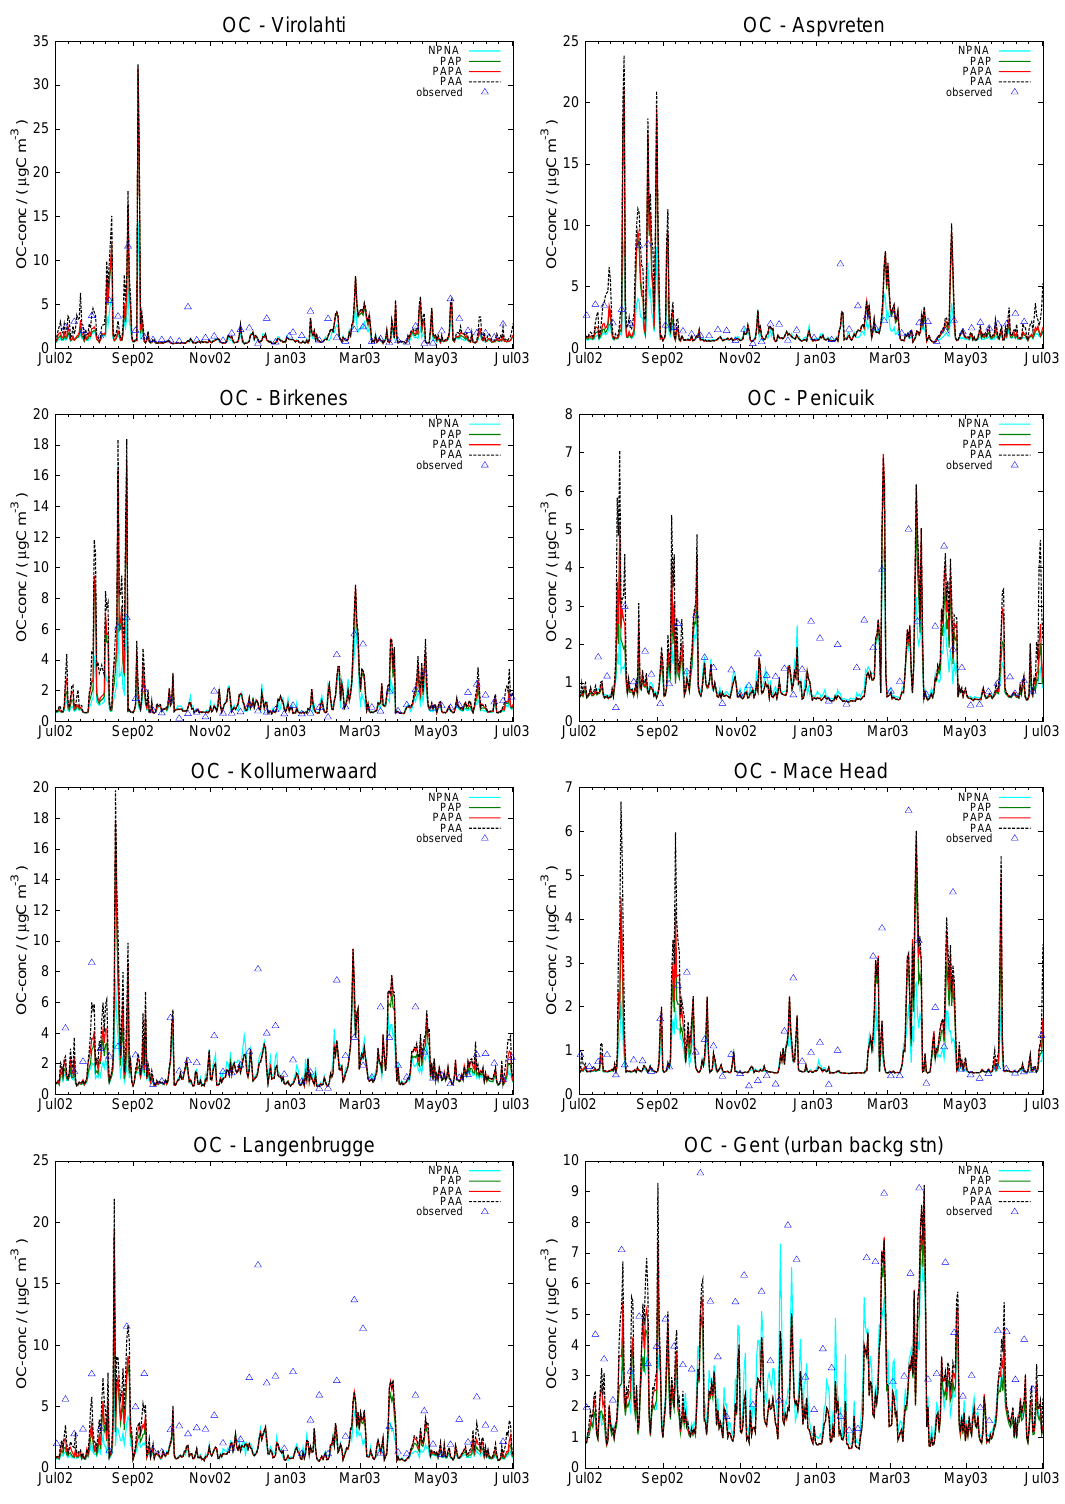
Fig. 9a. Modelled versus observed OC from the EMEP EC/OC campaign 2002–2003, at sites arranged from north to south. Measured total OC-concentrations (24h filter measurements) are indicated with triangles. Units: µg ( C ) m − 3